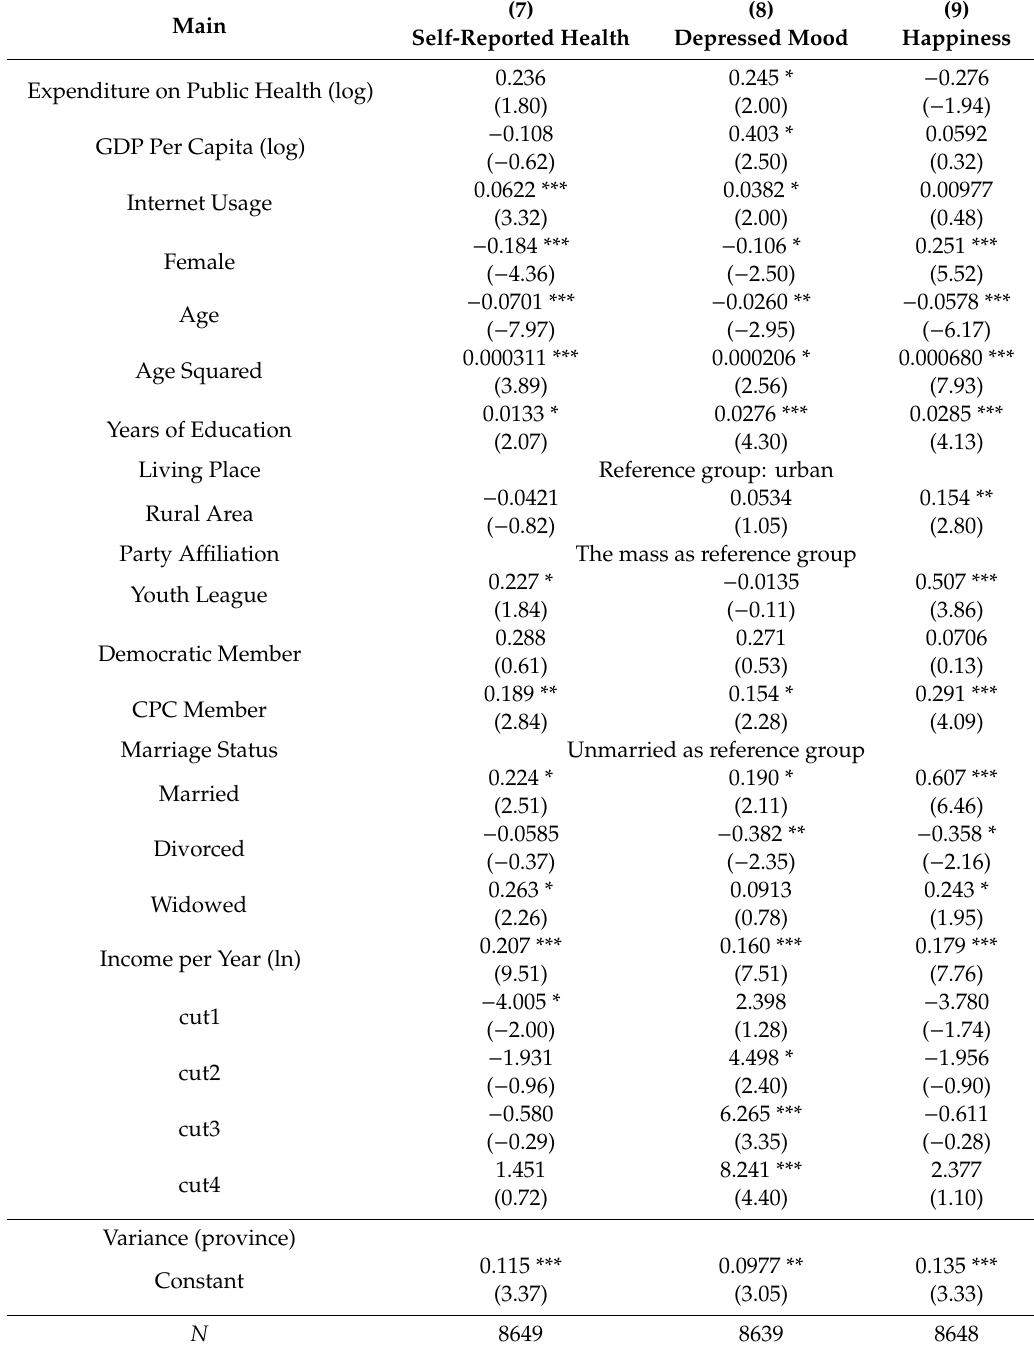
Table 3. Two-level hierarchical regression